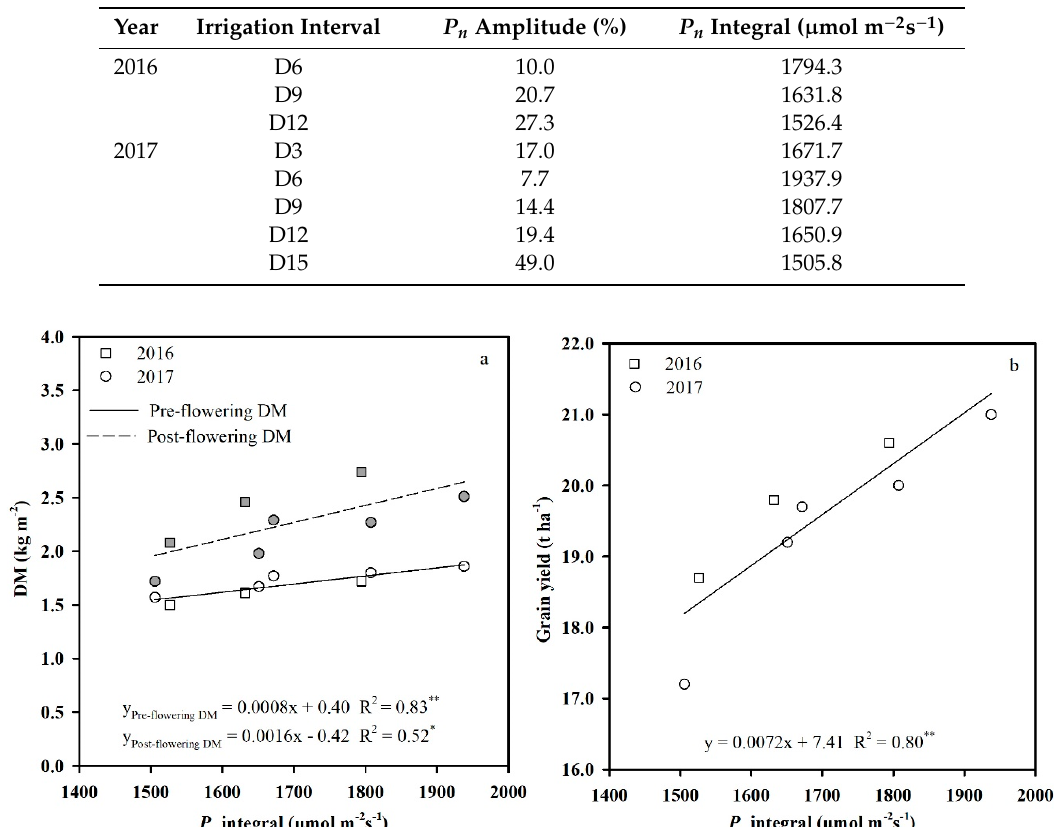
Figure 3. The relationship between photosynthetic rate integral and dry matter accumulation (DM) ( a ) and grain yield ( b ). * significant at 0.05 level; ** significant at 0.01.